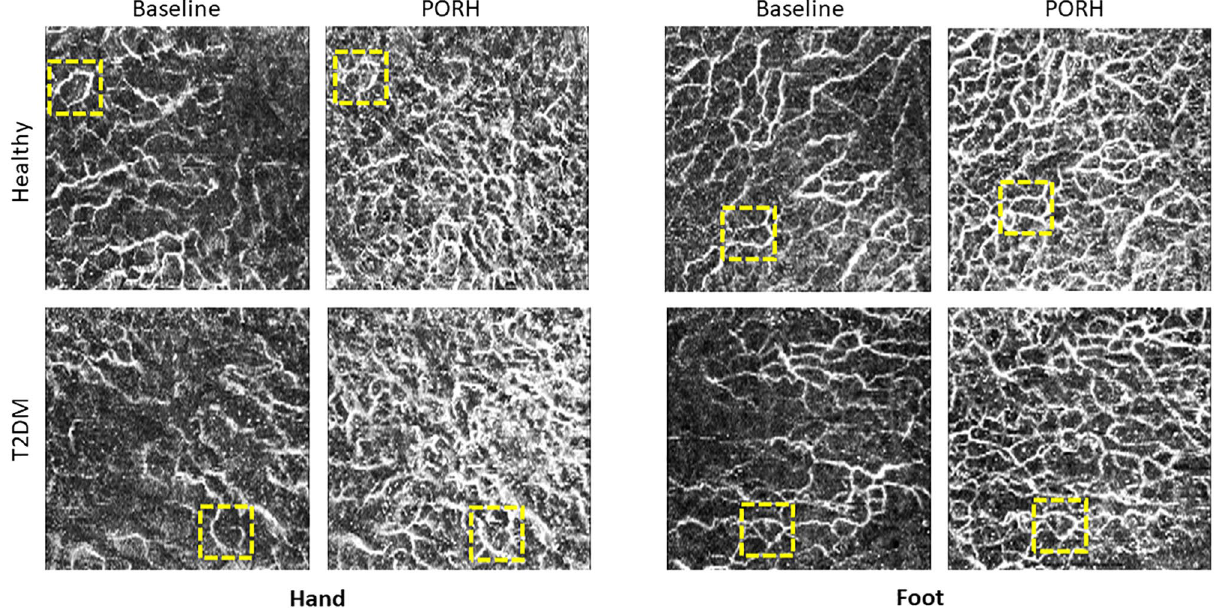
Figure 1. Representative OCTA MIP images from the hand (left) and the foot (right) representing the healthy group (top) and the diabetic group (bottom). All images are from participants in the 50–60 years old age group. All images are 5 × 5 mm. Dotted yellow boxes indicate 1 × 1 mm identical regions in the baseline and PORH datasets and demonstrate the amount of misalignment between scans (< 5% linear offset in x, y dimensions on average for all images).